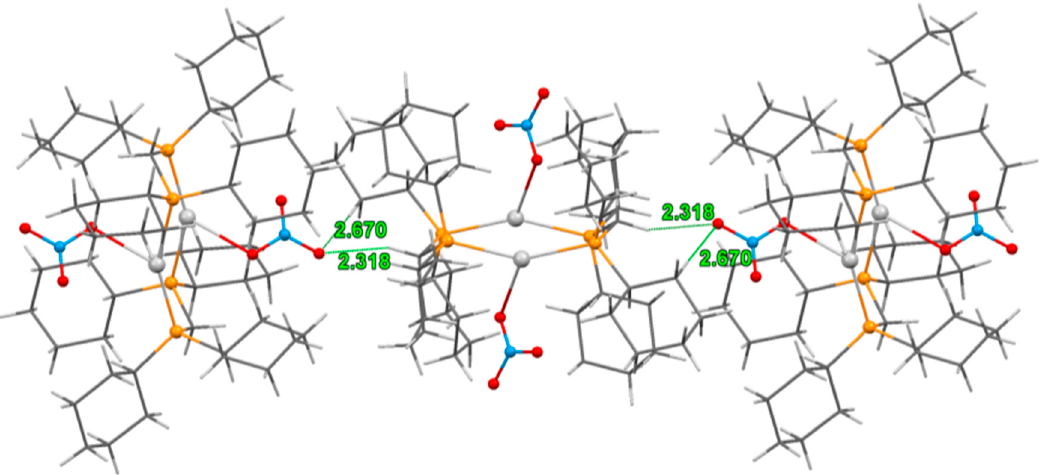
Figure 2. Supramolecular packing of 1 .